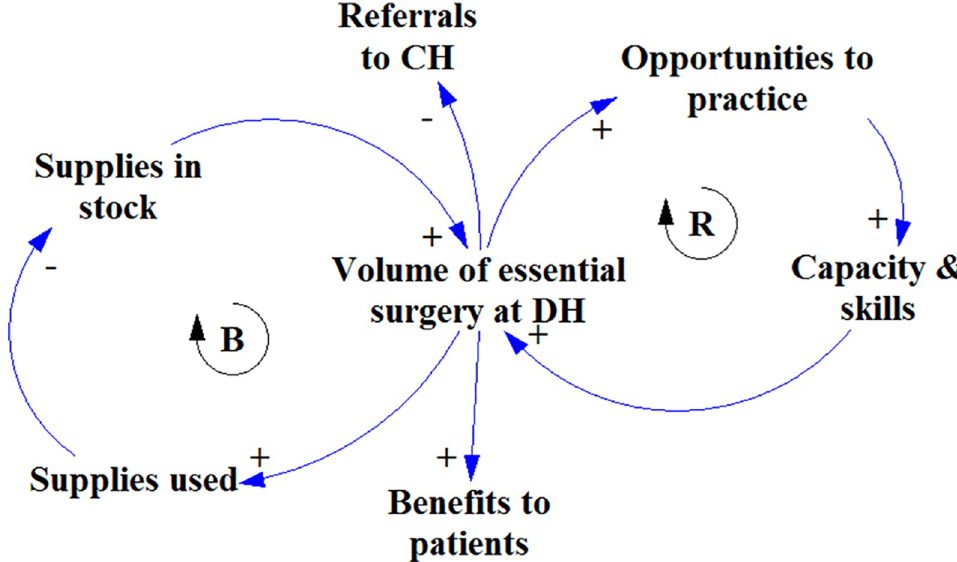
Fig 1. Simple causal loop diagram that was used as a starting point in the first three group model building workshops. In addition, it was used to explain the concepts of positive/negative relationships and reinforcing/balancing feedback loops. Plusses indicate relationships were factors change in the same direction, e.g. if volume of surgery goes up, supplies used goes up and if volume of surgery goes down, supplies used goes down. Minuses indicate negative or inverse relationships were factors changes in the opposite direction. So when volume of surgery goes up referrals decrease, and when volume of surgery goes down referrals increase. ‘B’ indicates a self-correcting or balancing feedback loop. ‘R’ indicates a self-reinforcing feedback